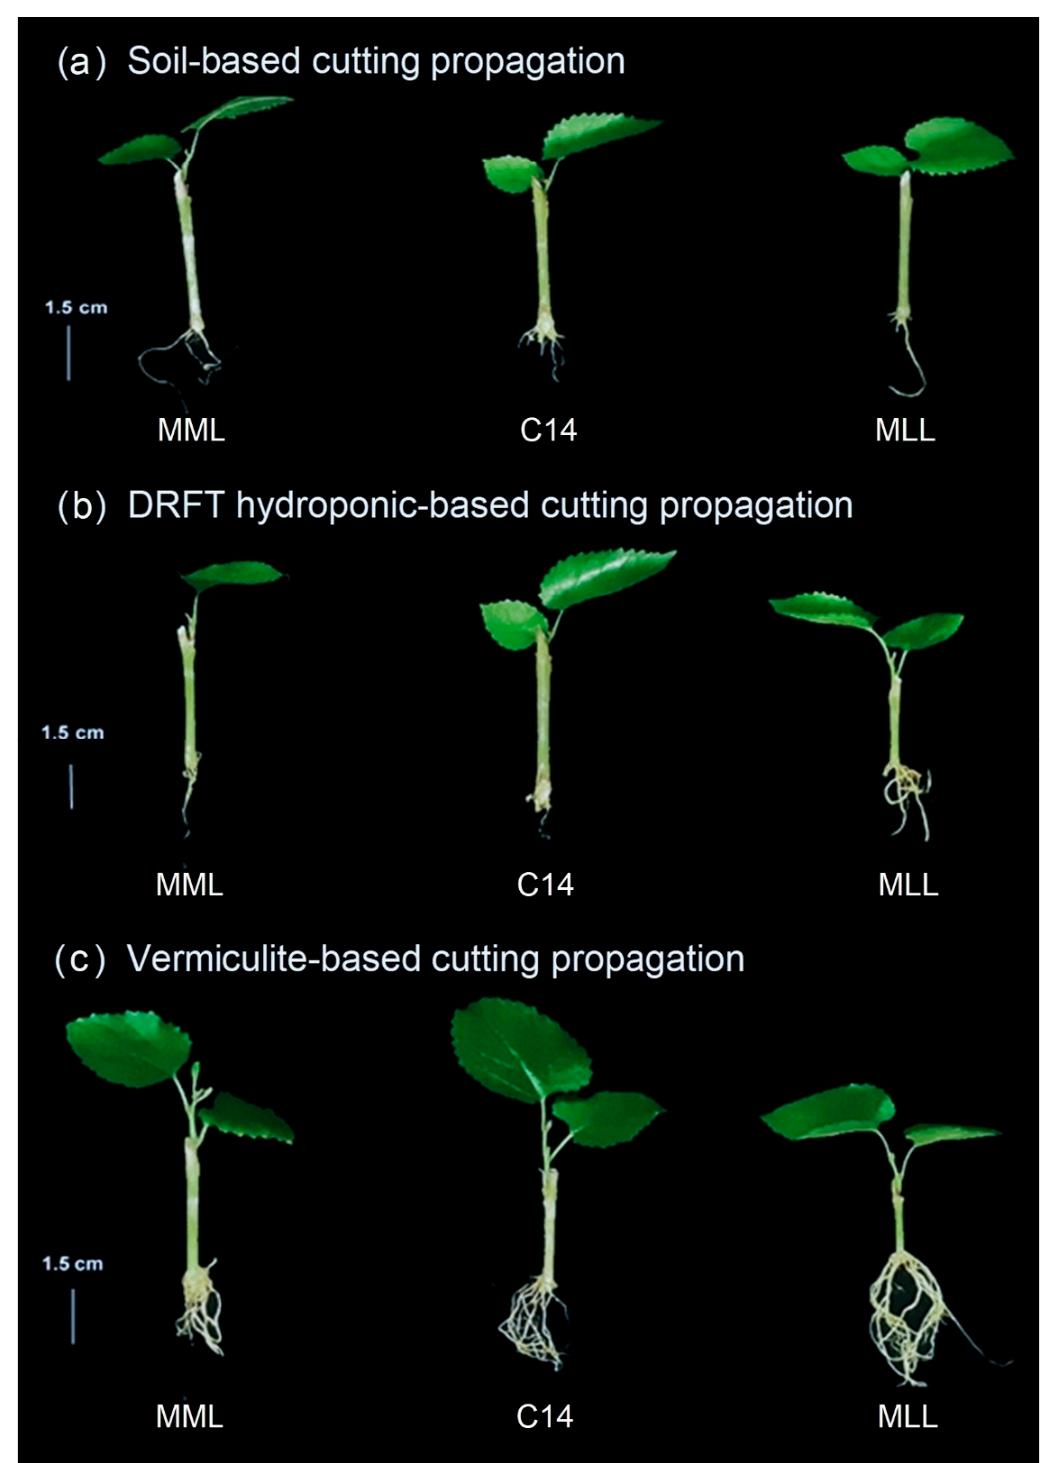
Figure 1. The shoot/root formation of mulberry transplants induced from single–node cuttings of three mulberry cultivars: Myanmar medium leaf (MML), C14, and Myanmar large leaf (MLL), after 30 days of cutting in three different substrates of soil ( a ), DRFT hydroponic– ( b ) and vermiculite–based systems ( c ).